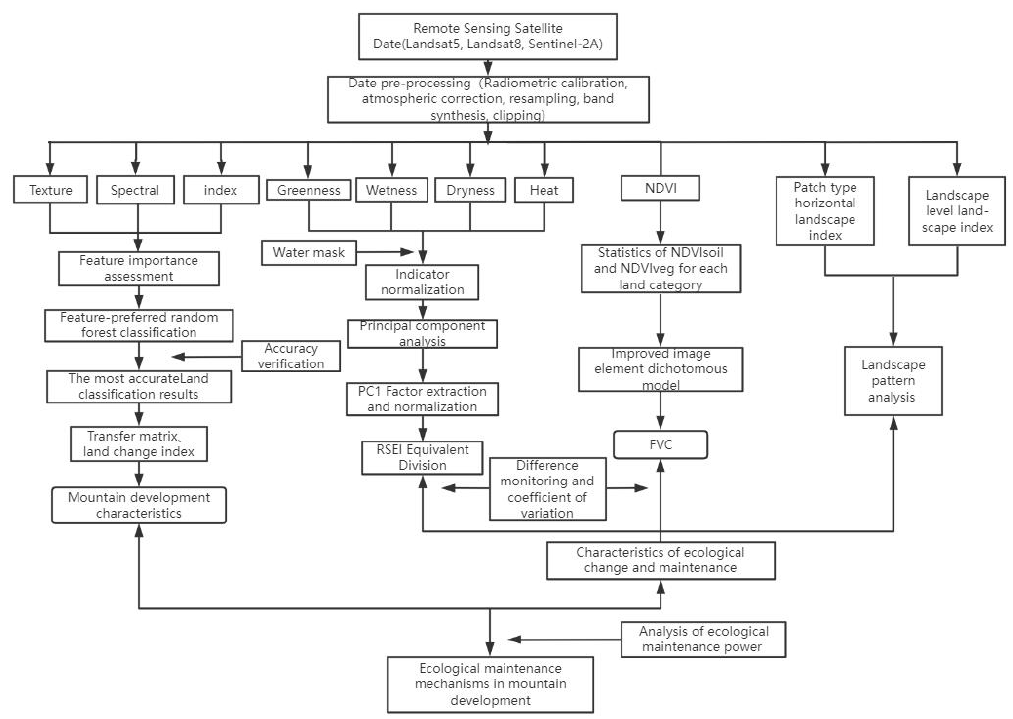
Figure 2. The flow chart of this study.